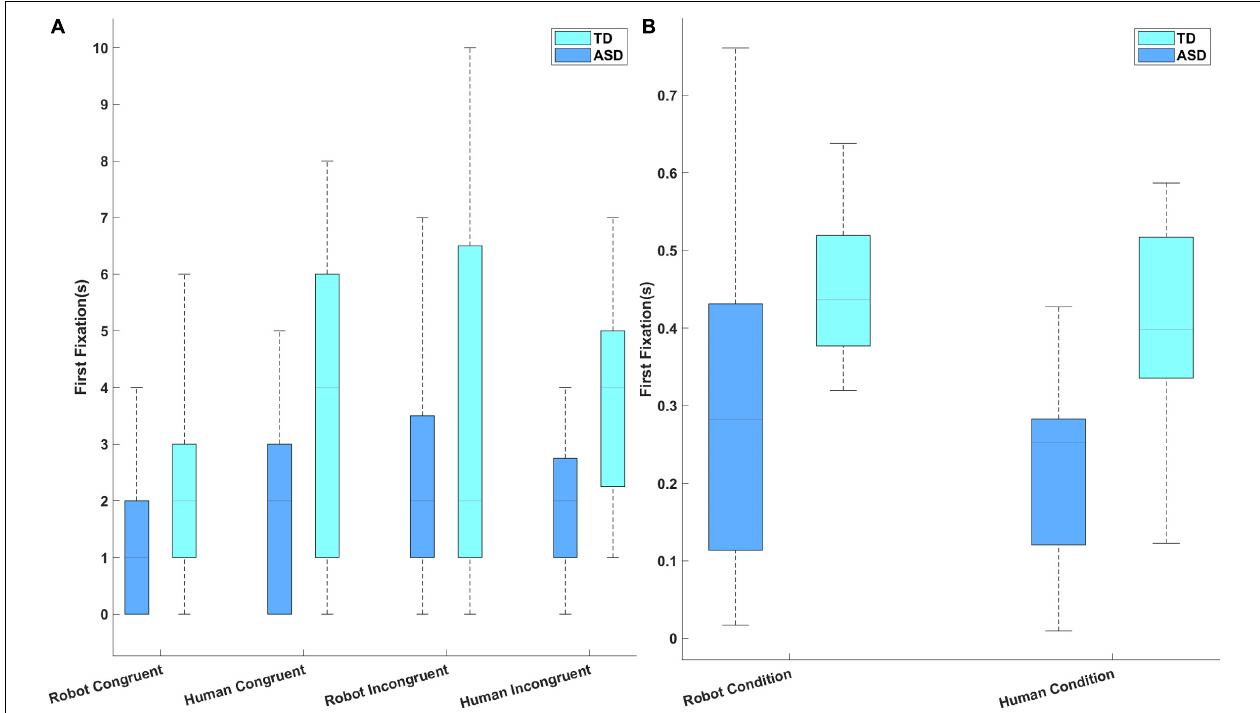
FIGURE 5 | (A) The number of congruent and incongruent gaze transitions made by each participant group for each stimulus types. (B) Longest common subsequence (LCS) scores for each participant group and stimulus